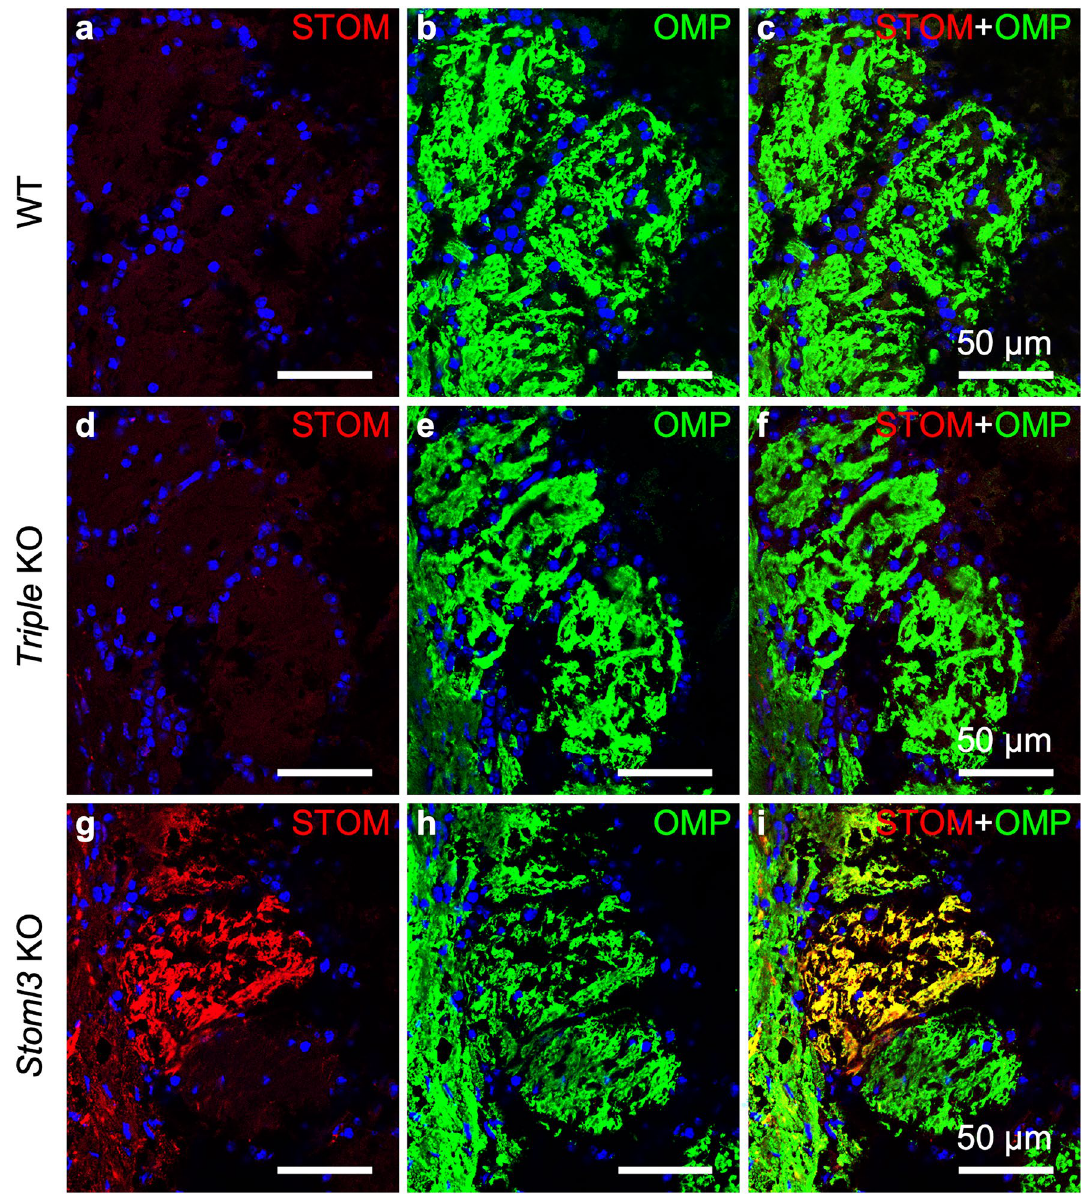
Figure 4. STOM expression in the olfactory bulb. Confocal micrographs of coronal sections of the OB of WT ( a – c ), triple KO ( d – f ), and Stoml3 KO ( g – i ) mice, double-stained with anti-STOM (red) and anti-OMP (in green) antibodies. In WT mice, STOM is not detected in the OB. Triple KO ( d – f ) mice do not display any staining with anti-STOM antibodies. In contrast, in Stoml3 KO mice, STOM strongly mis-localizes in the glomeruli ( g – i ). Nuclei were stained with DAPI